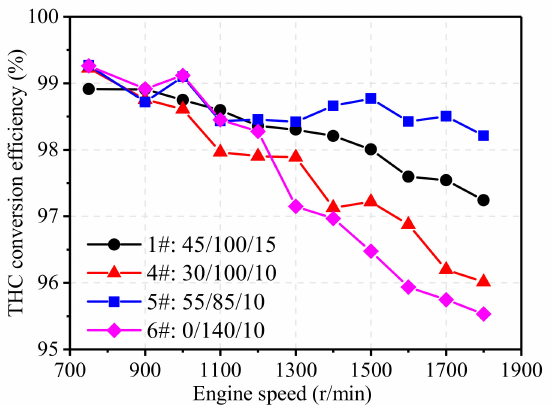
Figure 14. E ff ect of noble metals ratio on THC conversion e ffi ciency.